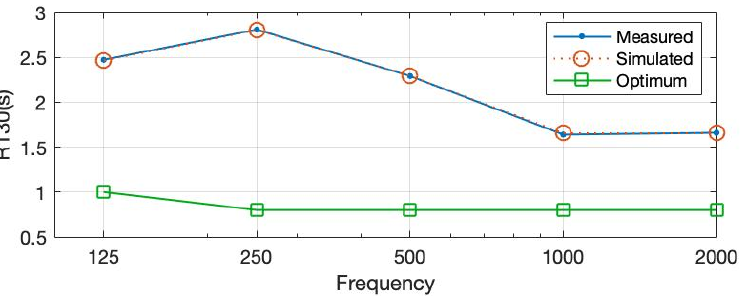
Figure 12. RT30 values for measured and simulated existing conditions compared to optimum ones.